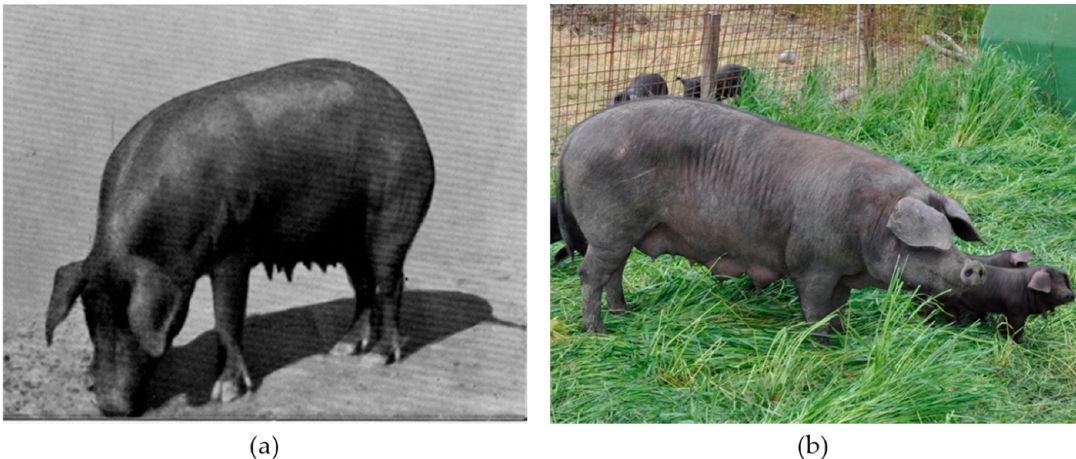
Figure 1. ( a ) An example of the original type called “Nera Parmigiana” found in an historical